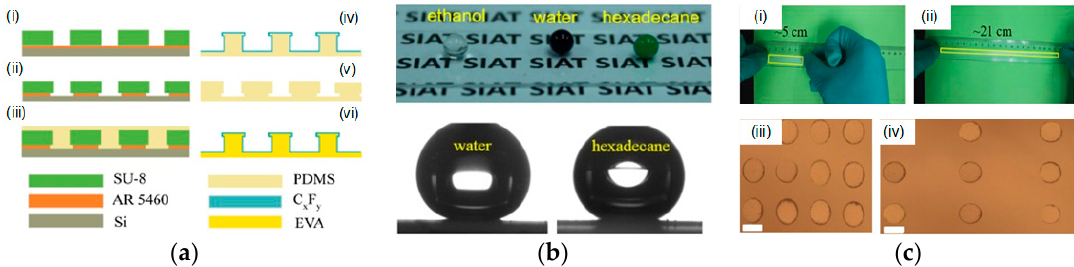
Figure 6. ( a ) Fabrication process of the superhydrophobic EVA film: ( i ) Spin-coating a thick resist (SU-8) followed by a thin resist (ARP-5460) and patterning the SU-8; ( ii ) Over-developing the ARP-5460 resist to form inverse T-shaped microcavities; ( iii ) Casting PDMS using standard soft lithography; ( iv ) Peeling the PDMS intermediate template off the microcavities, and coating C x F y on T-shaped PDMS pillars using C 4 F 8 plasma; ( v ) Casting PDMS onto the PDMS mold and peeling-off; ( vi ) Pouring EVA film onto the PDMS intermediate mold and peel off after curing, then low surface tension treatment with F-SAM. ( b ) Transparency of the as-prepared EVA film adhered to paper, and the excellent superhydrophobicity of the EVA SLS film (contact angle: 157.6° for water and 148.8° for hexadecane). ( c ) EVA SLS film: ( i ) before and ( ii ) after, stretching, and the corresponding microstructural profiles in ( iii ) and ( iv ). All scale bars are 10 µm. Reproduced from [90] with permission; Copyright Elsevier